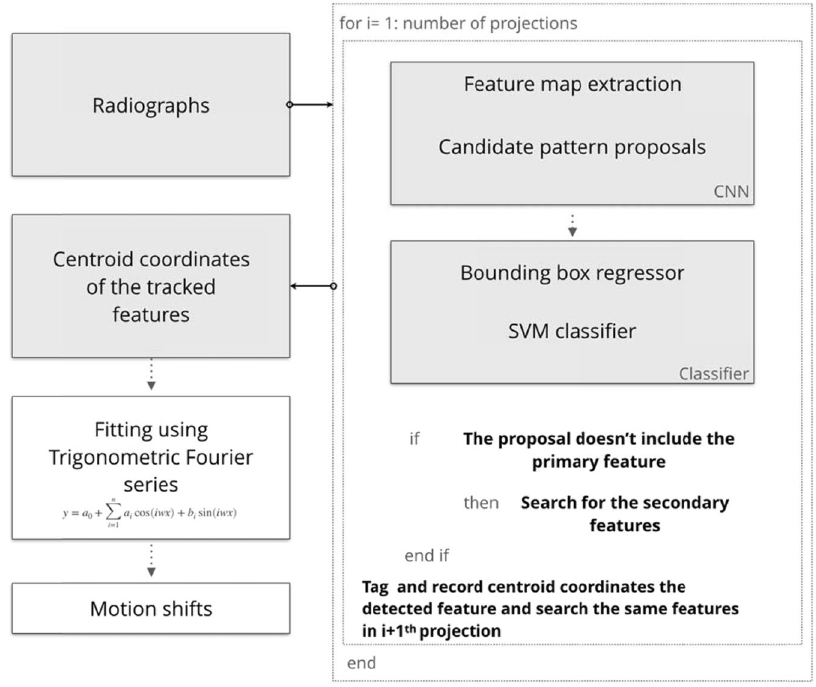
Figure 12. The algorithmic workflow of proposed feature detection and tracking